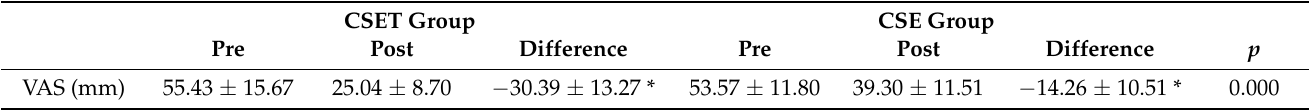
Table 2. Subject scores of pain intensity before and after